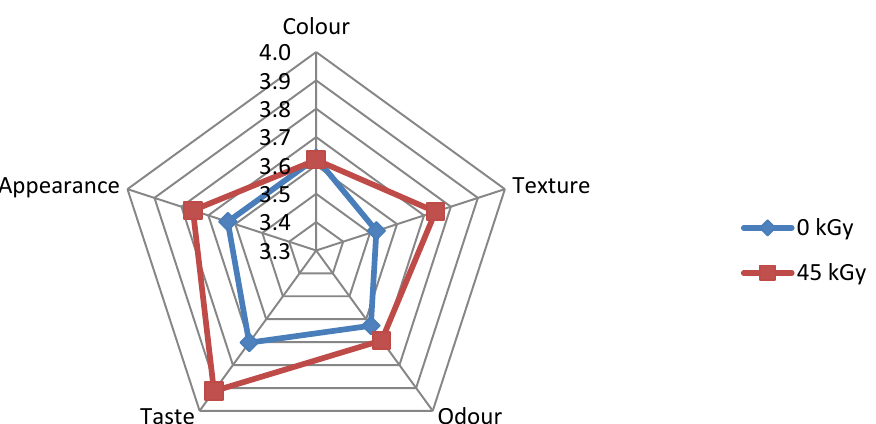
Figure 3. Sensory evaluation of non-irradiated and irradiated pepes gold fish.